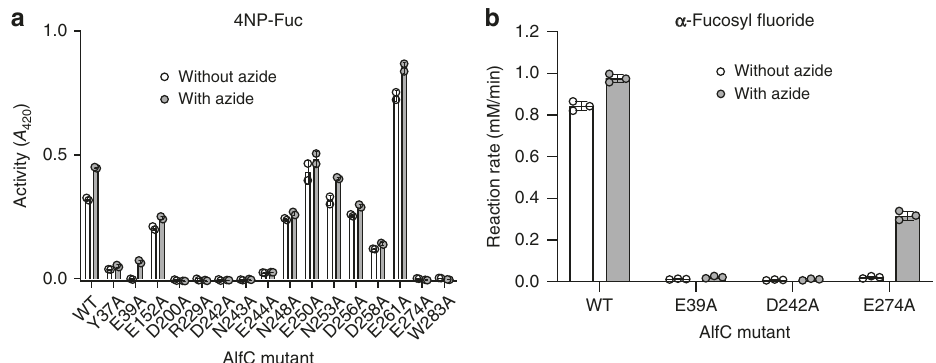
Fig. 4 Activity and azide rescue of AlfC WT and point mutants. a Reactions were measured in duplicate on separate samples with 4NP-Fuc as substrate. b Reactions were measured in triplicate on separate samples with α -fucosyl fl uoride as substrate. Error bars represent the standard deviation of n = 3 independent experiments. Data are presented as mean values± SEM. Source data are provided as a Source Data fi le.